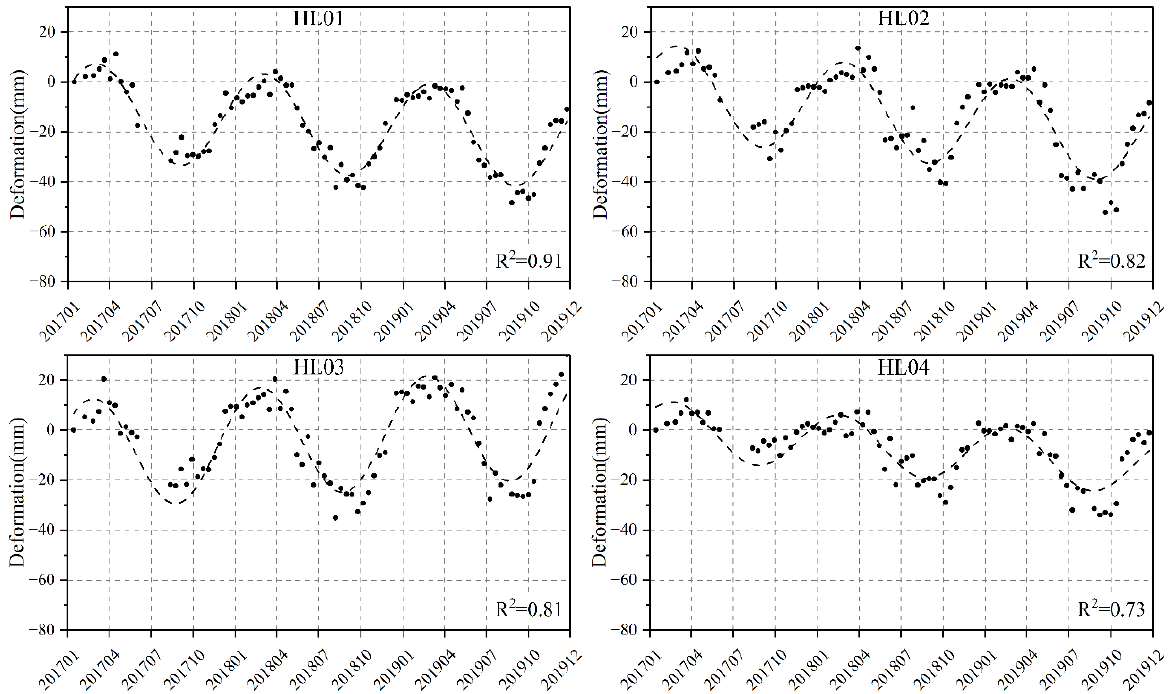
Figure 5. Seasonal deformation time series at boreholes. The black solid point is the deformation observed by SBAS-InSAR, and the black dotted line is the model fitted curves.